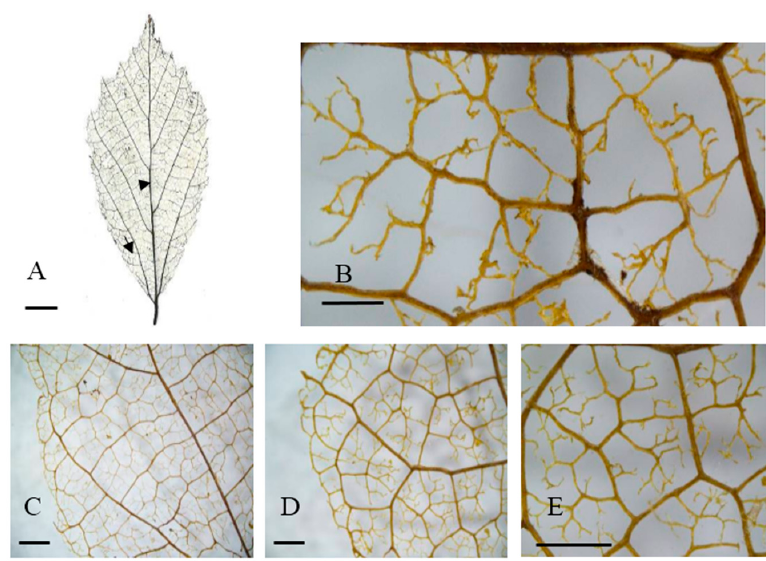
Figure 4. Leaf venation of valley trees in eastern China. ( A ) General vein pattern; ( B , E ) Areolation; ( C , D ) Looped marginal ultimate venation. Arrowhead: basal veins. ( A ) Tongcheng, Anhui; ( C , D ) Tongcheng, Anhui; ( D , E ) Jixi, Anhui. Arrow: agroaphic veins. Scale bar: ( A ) 1 cm; ( B ) 500 µm; ( C – E ) 1000 µm. Table 3. Leaf venation pattern of P. subaequalis in eastern China. FEV, freely ending veinlets; P, pentagonal; PE, percurrent; Q, quadrangular; R, reticulate; T, triangular.